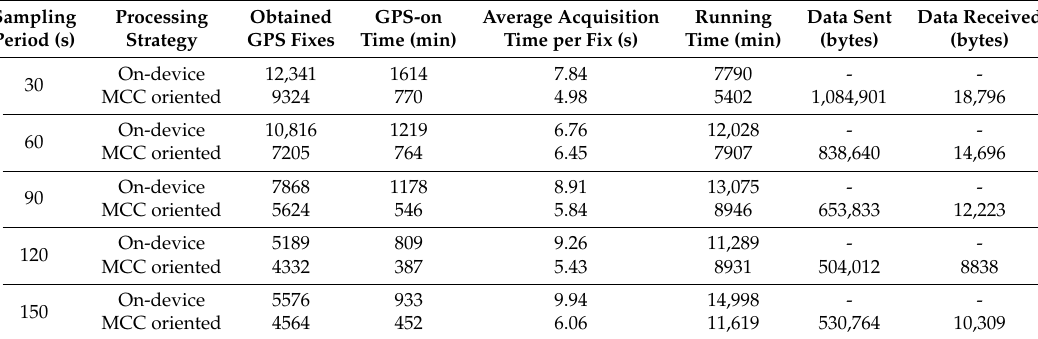
Table 3. Summary of results of second